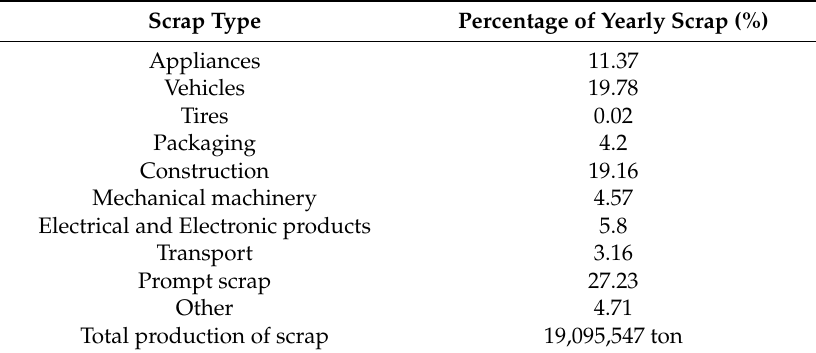
Table A5. Results from 2014 World Steel Association scrap survey [25].